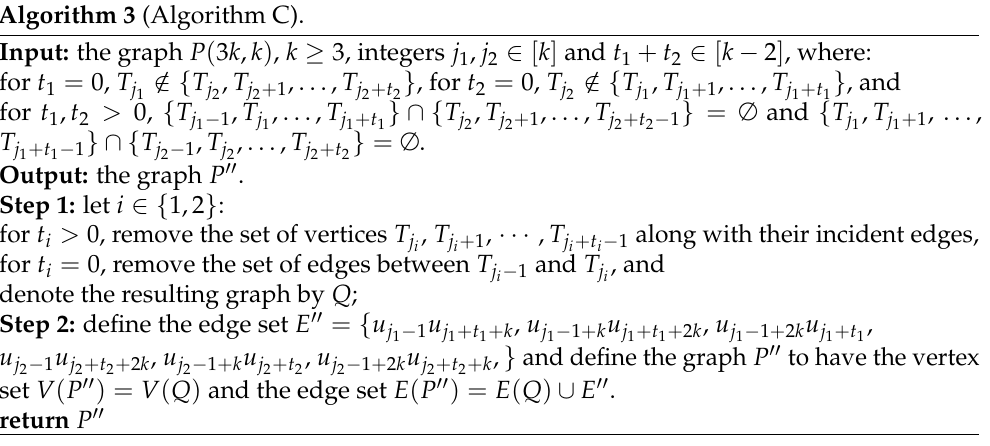
Figure 5. Illustrating Algorithm B for constructing P (cid:48) from P ( 3 k , k ) . Algorithm 3 (Algorithm C).